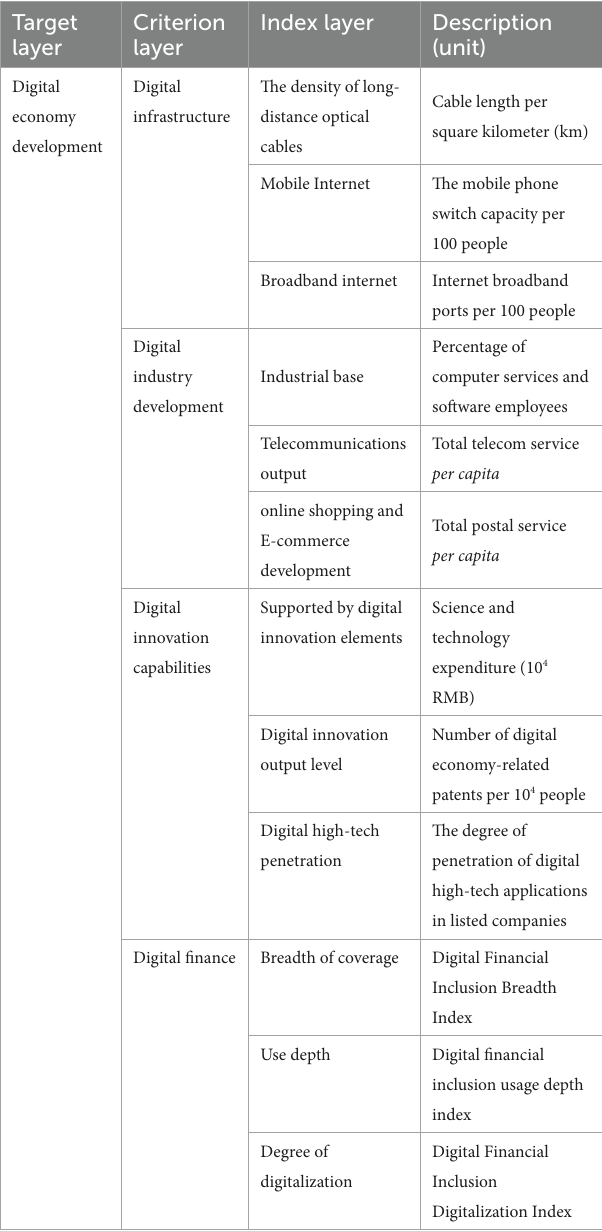
TABLE 1 Digital economy development comprehensive index